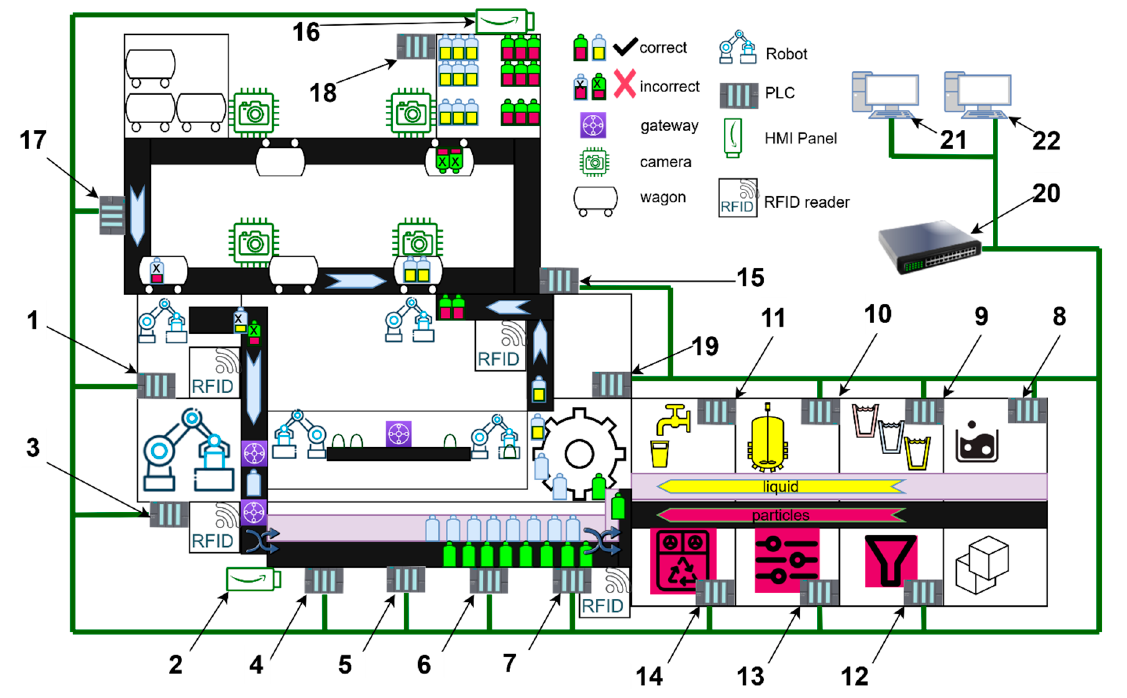
Figure 2. Model of production line.